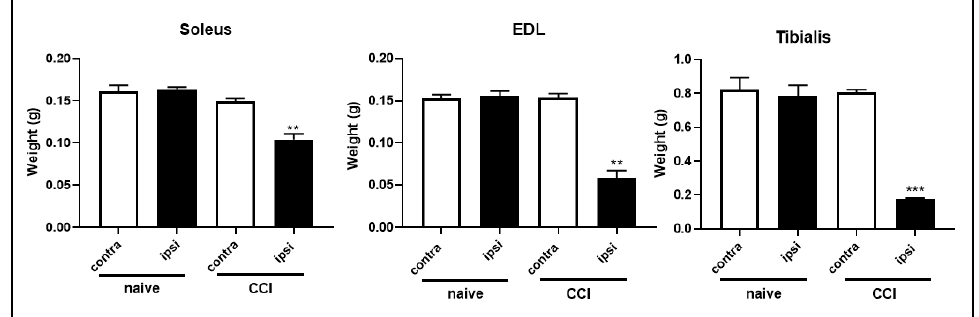
Figure 3. Skeletal muscle weight at the end of the study. Ipsilateral skeletal muscle weight in animals subjected to intervention was always lower compared to that of contralateral muscles. The results are expressed as mean ± S.E.M. **: p < 0.01, ***: p < 0.001 vs. contralateral.